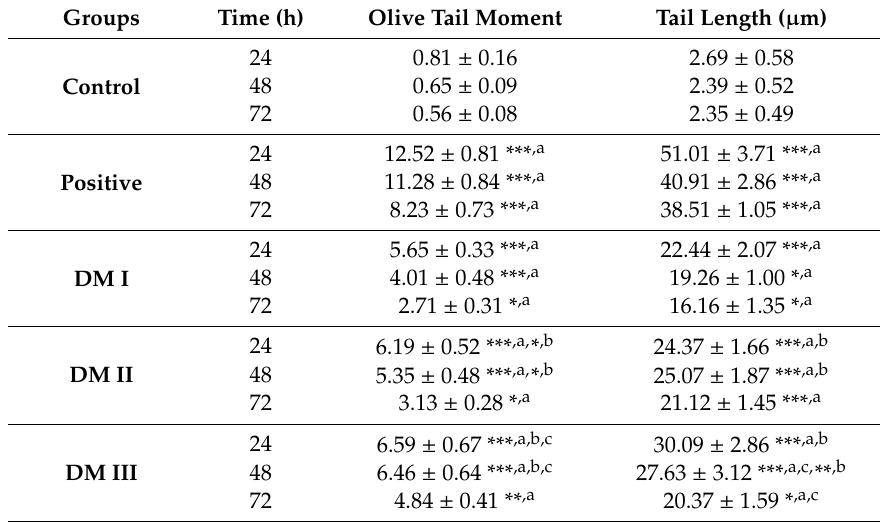
Table 3. E ff ect of multiple sub-lethal doses of Dimethoate acute exposure on comet assay parameters analyzed in whole blood of Rattus